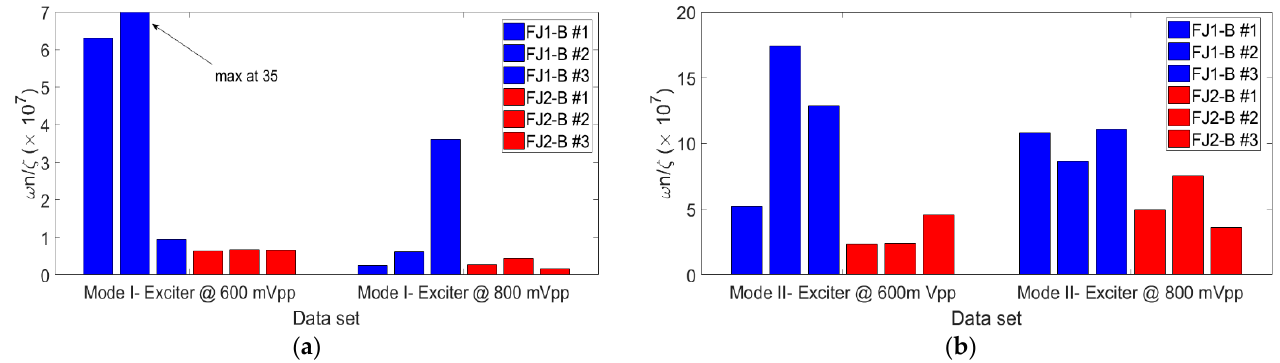
Figure 6. Bar plots indicating the values of ω n / ζ for tests conducted with the exciter driven at 80 Hz with amplitude of 600 and 800 mVpp: ( a ) Mode I; ( b ) Mode II (see Tables 2 and 3 for more information on modes).